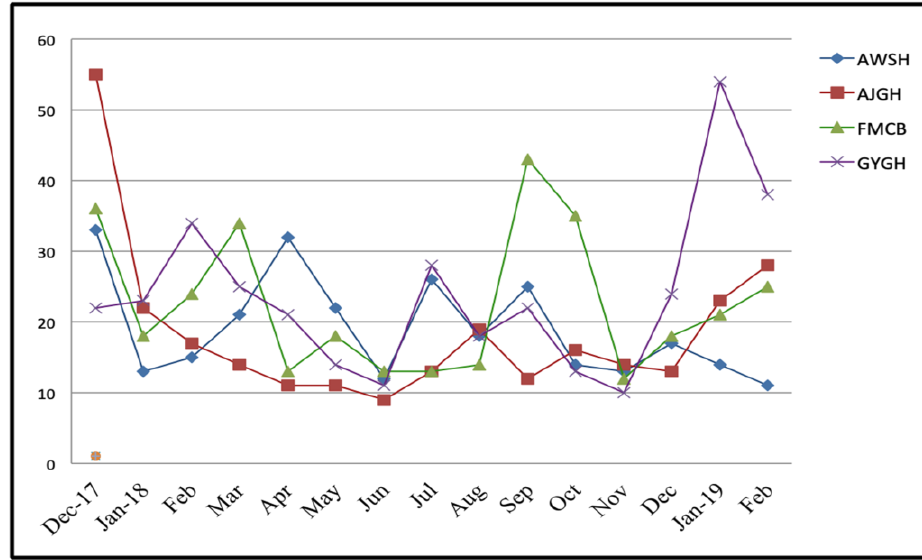
Figure 2. The data collection flow of diabetes patients from the four hospitals.